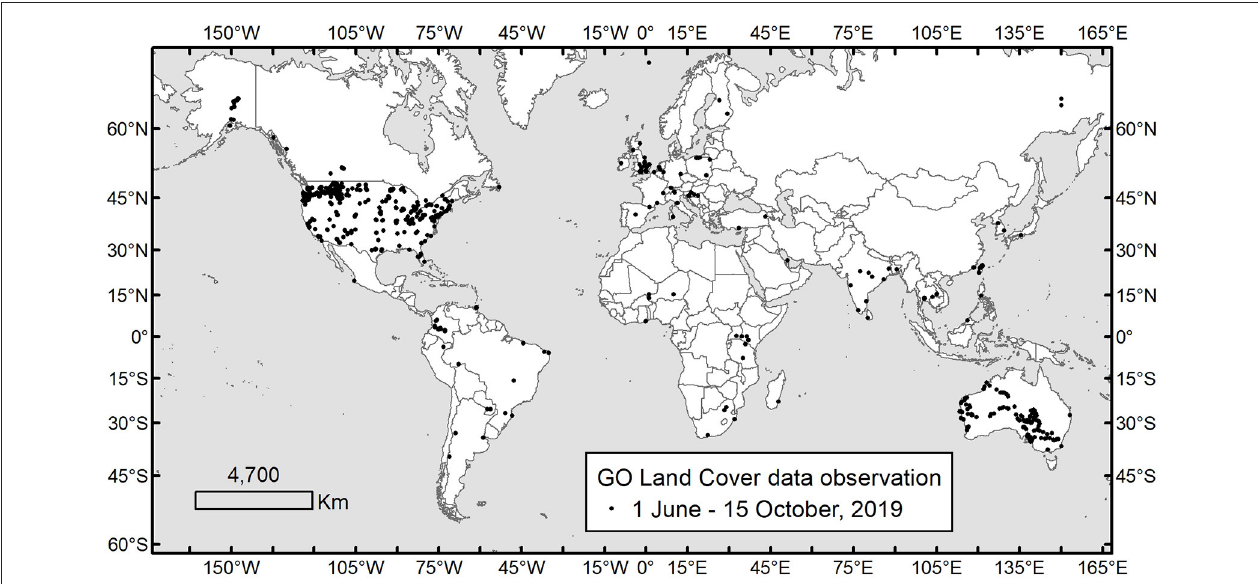
FIGURE 4 | Distribution of ground reference images collected globally using the GLOBE Observer mobile app with the Land Cover protocol during the GO on a Trail data campaign that occurred from June 1 to October 15, 2019. Observations were reported from every continent except Antarctica, but are most concentrated in North America and Australia where partner-led challenges drove data collection.